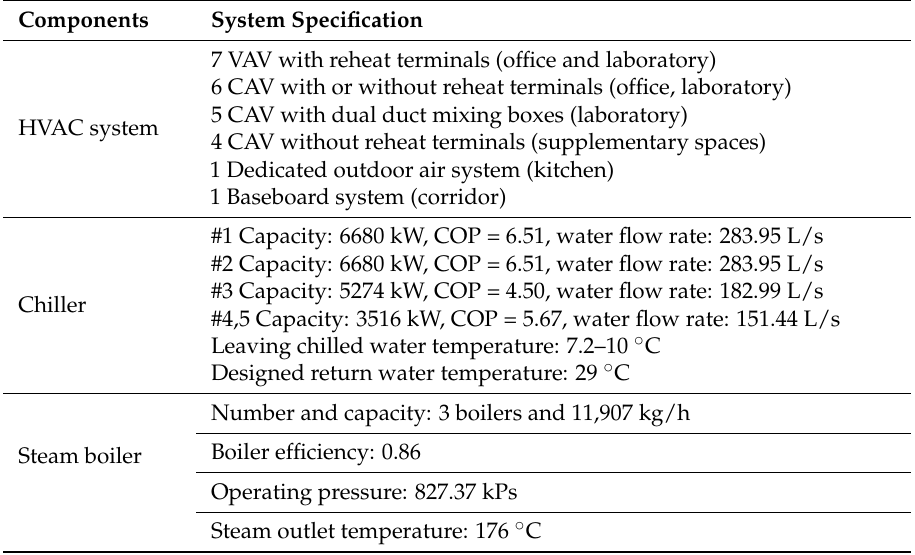
Table 2. Configurations of the primary and secondary